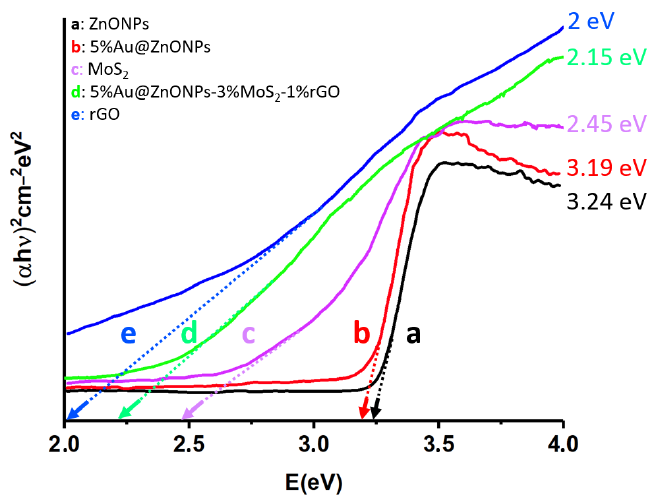
Figure 6. Tauc plots of (αhn) 2 versus energy (eV), and determination of the bandgap energy of ZnONPs ( a ); 5%Au@ZnONPs ( b ); MoS 2 ( c ); 5%Au@ZnONPs-3%MoS 2 -1%rGO ( d ); and rGO ( e